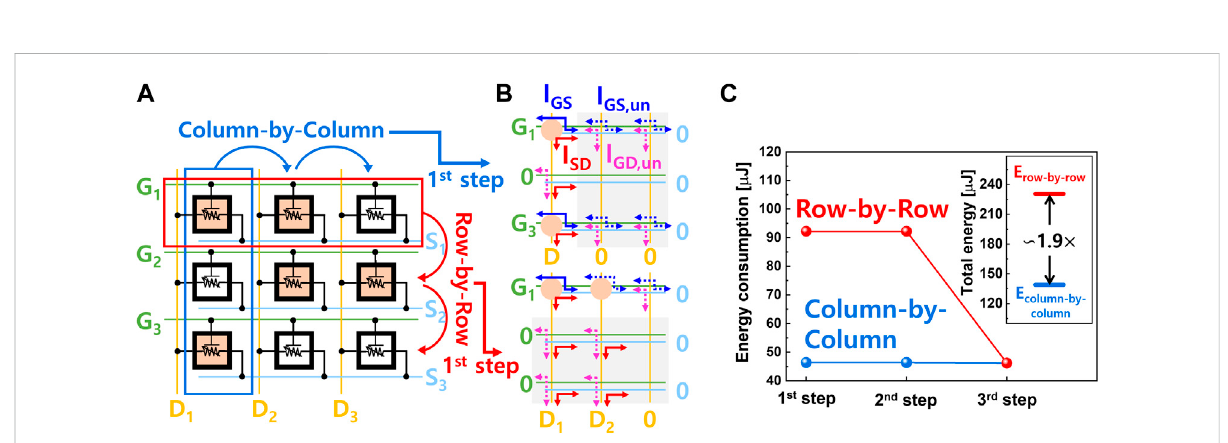
updated in two ways: column-by-column or row-by-row. Three steps of updates were sequentially executed, but different combinations of selected cells and unselected cells were assigned in each step (Figure 4B). Considering the fi rst update step, D 1 solely needed to be activated, while G 1 and G 3 were turned on during column-by-column scheme (top of Figure 4B). Thus, the I G,un was the primary leakage source through the rest of the columns. However, to update the same